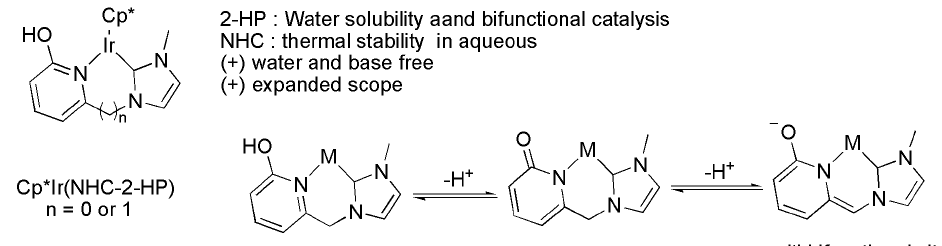
Figure 31. Design of bifunctional Cp*Ir complexes [245]. Cp* = Me 5 ‐ Cp.